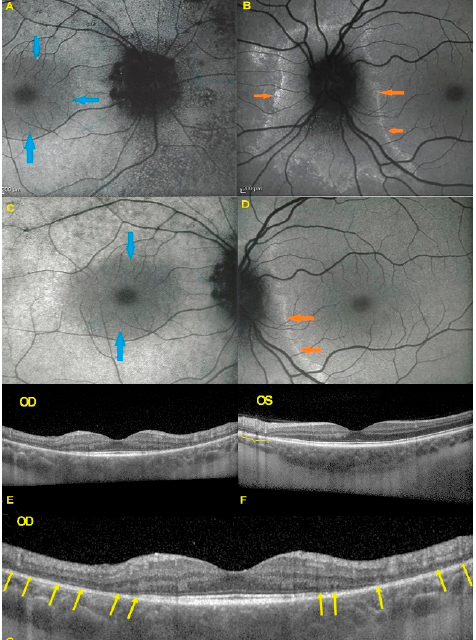
Figure 2. BL-FAF & SD-OCT in AZOOR patient 1 at presentation. ( A ) Increased FAF of the whole posterior pole OD ( A , C ) except the central foveolar and peri-foveolar area (blue arrows) explained by the loss of the screen of the photoreceptor outer segments as shown on the SD-OCT ( G ) sections (yellow arrows). On the left eye in FAF ( B , D ) there is peripapillary hyperautofluorescent demarcating line (orange arrows) corresponding also to a limited area of loss of photoreceptor outer segments ( E – G , yellow bracket in F , yellow arrows in G ).